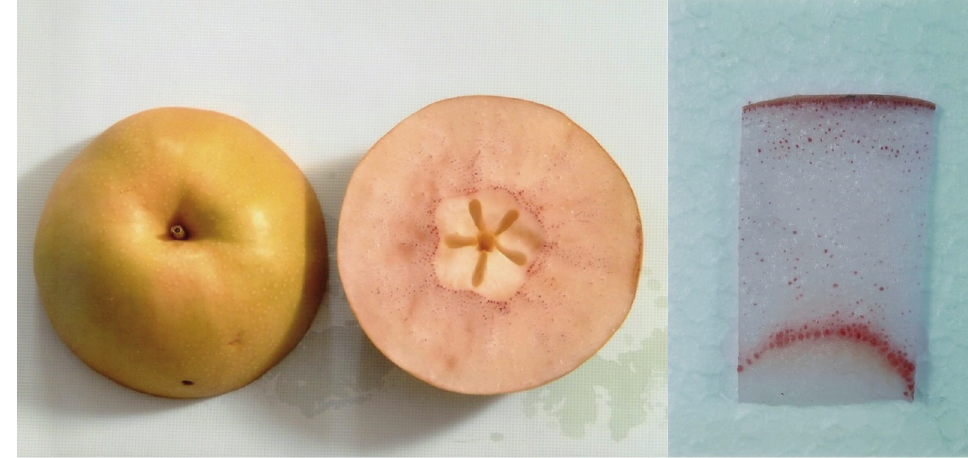
Fig. 5: Confirming of stone cells by 3% phloroglucinol-HCl dye at 150 DAFB in fresh of ‘Niitaka’ pear.